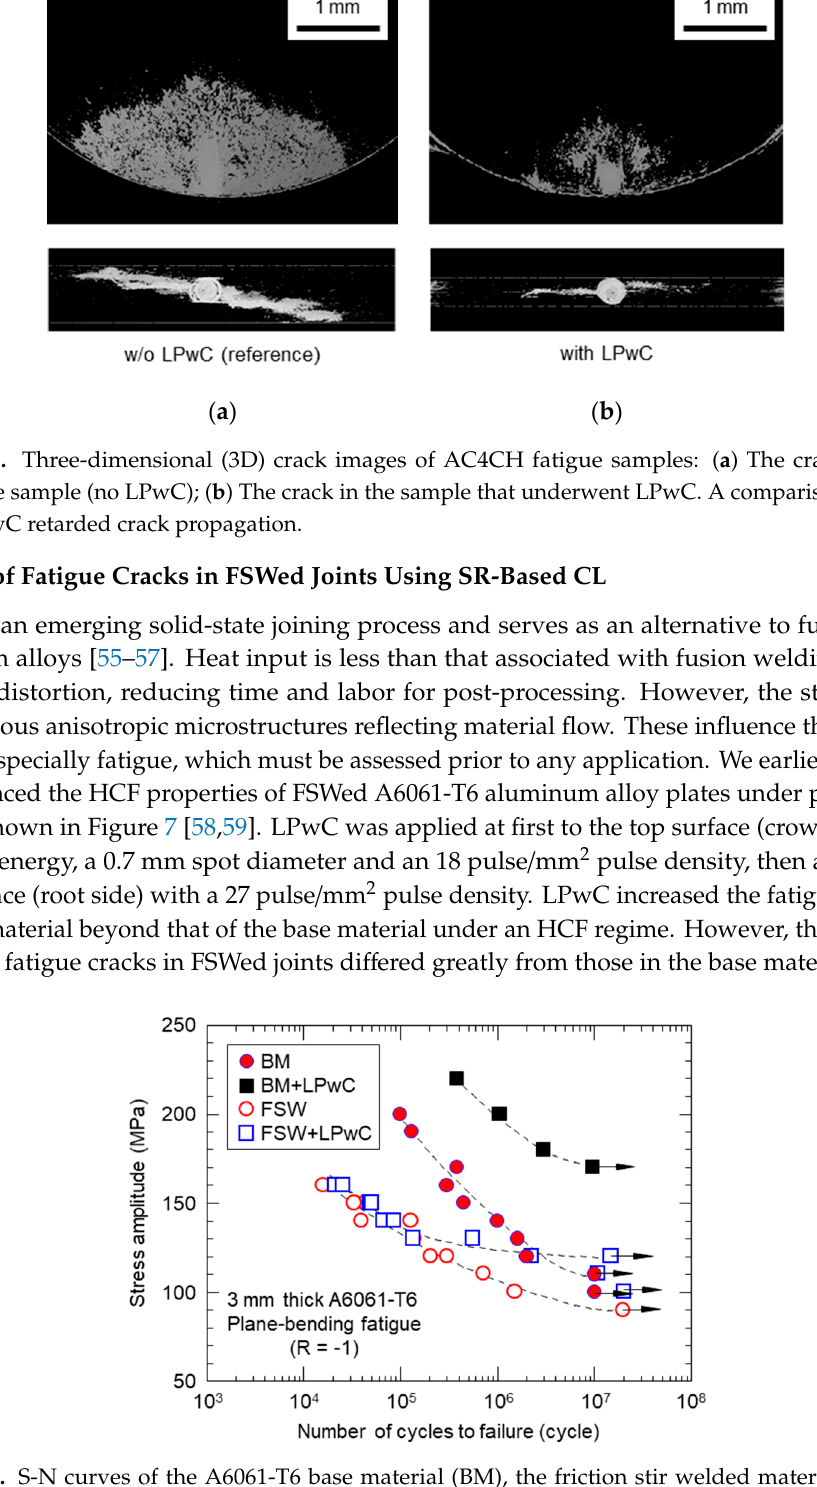
( b ) A plot of the linear attenuation coefficients along the line A-A’ of Figure 5 ( a ). The border between